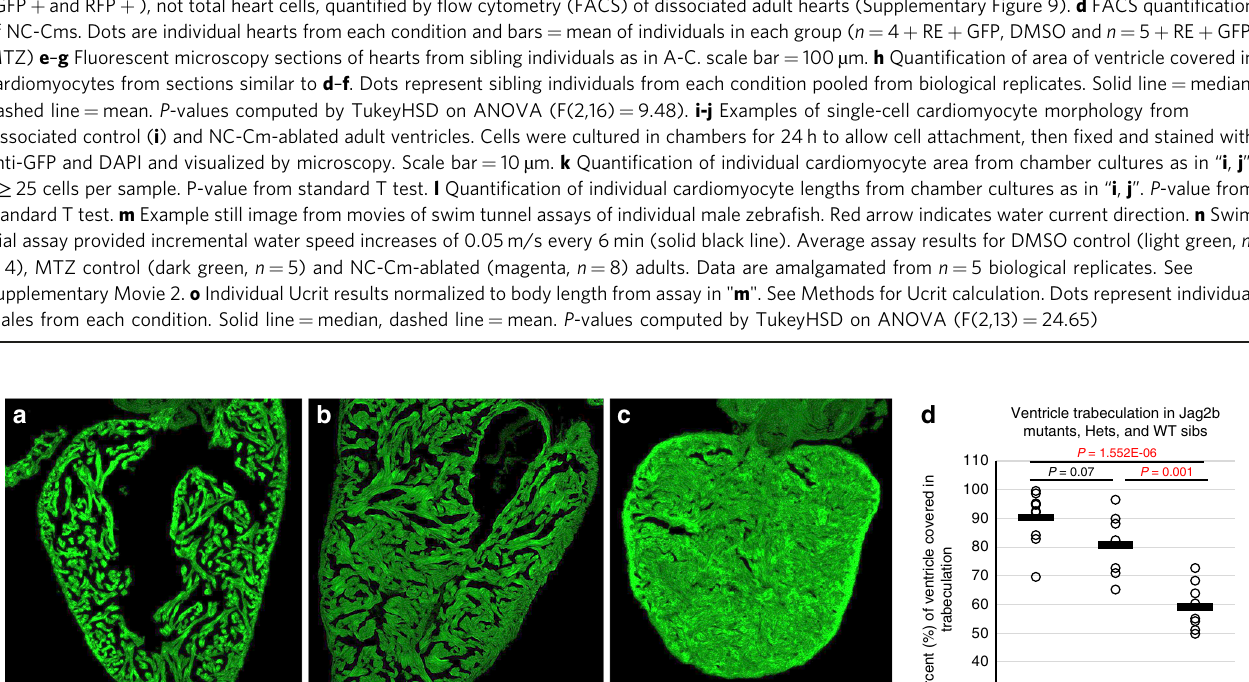
Fig. 5 Jag2b mutant adults phenocopy hypertrophic cardiomyopathy of the NC-Cm ablated adults. a – c Microscopy sections of adult ventricles from jag2b wild-type ( + / + ), heterozygous ( + /-), and homozygous (-/-) mutants. Sections were stained with phalloidin-488 and imaged. Scale bar = 100 µ m. d Area of ventricle with 488 + trabecular myocardium was quanti fi ed as in 4 H and tested for signi fi cance by two-way T